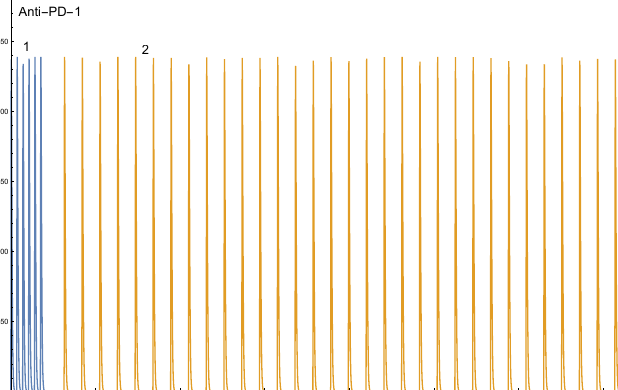
Figure 1. The y-axis represents the dosage of the ANTI PD-1 treatment and x-axis represents the time in days. The given dosage is 3 mg per kg. This figure presents a treatment for a patient weighing 82 kg. The scheduled administration and doses were: once a week infusion into the vein for 7 weeks, break in the treatment for 3 to 4 weeks, and then the treatment was repeated once a week. The dose was 242 mg each time. Line 1 presents the first period of treatment, that is, the first 7 weeks, and line 2 presents the second period of treatment.